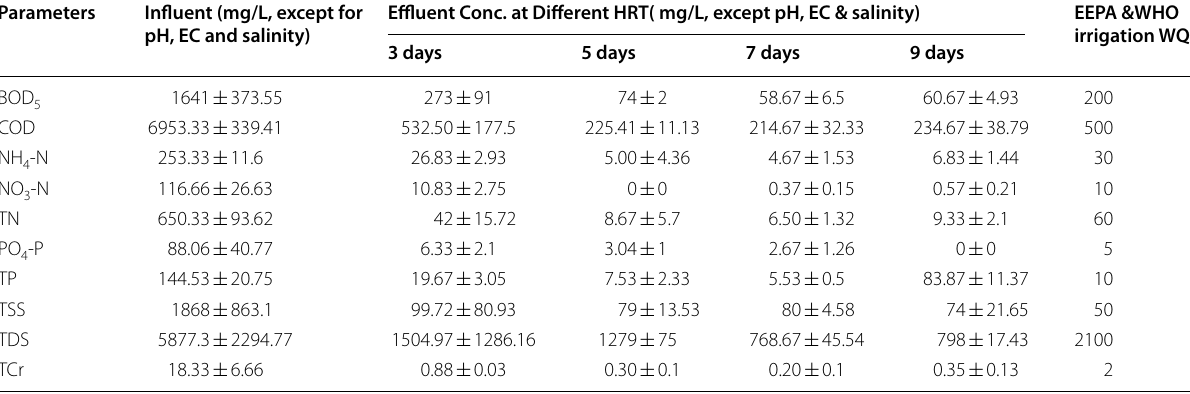
Table 2 Characteristics of treated wastewater by HSSFCW with pumice substrate and CZ at different HRT Parameters Influent (mg/L, except for pH, EC and